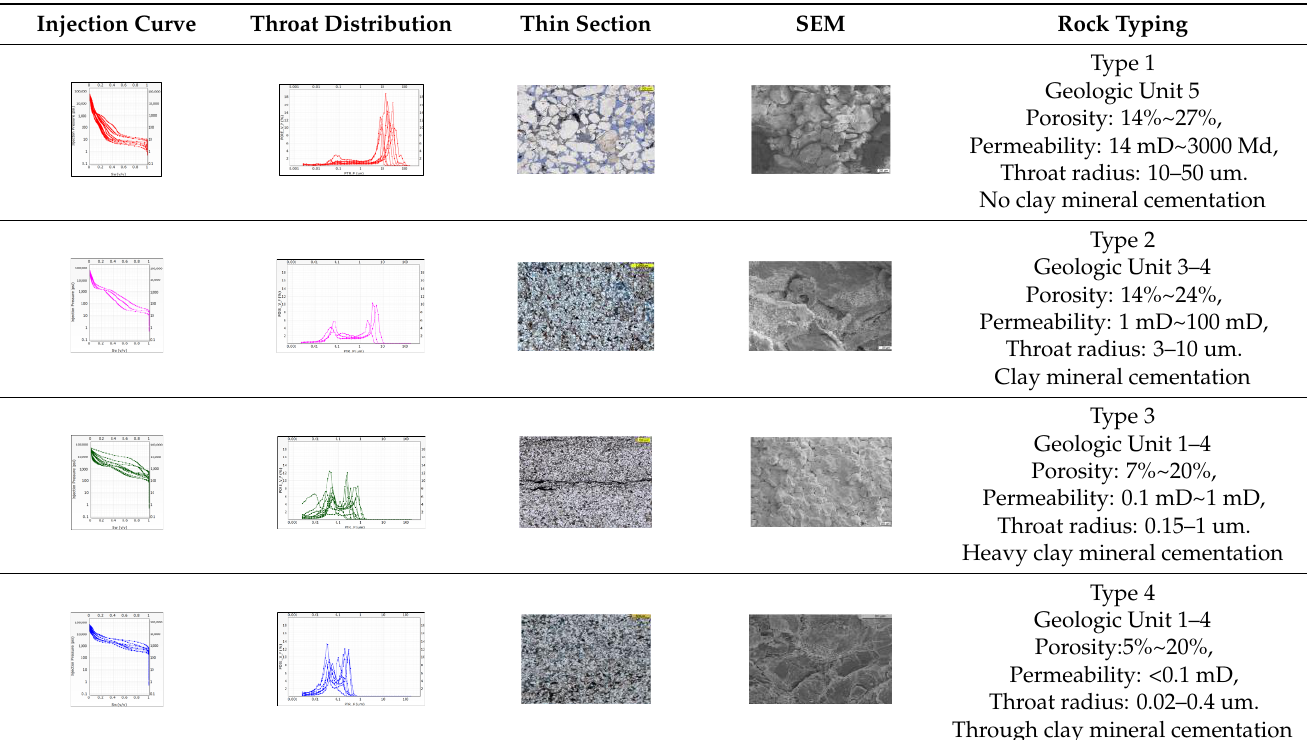
Table 3. The rock types defined in Miano gas field with their injection curve, throat size distribution, and representative photos of thin sections and SEM. Rock type 1 has the best quality and only exists in the conventional gas reservoir. Rock types 2 to 4 distribute in the tight gas reservoir.